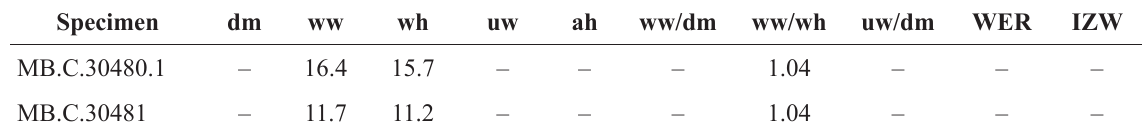
Table 15. Conch dimensions (in mm) and ratios of Maccoyoceras saharensis sp. nov.